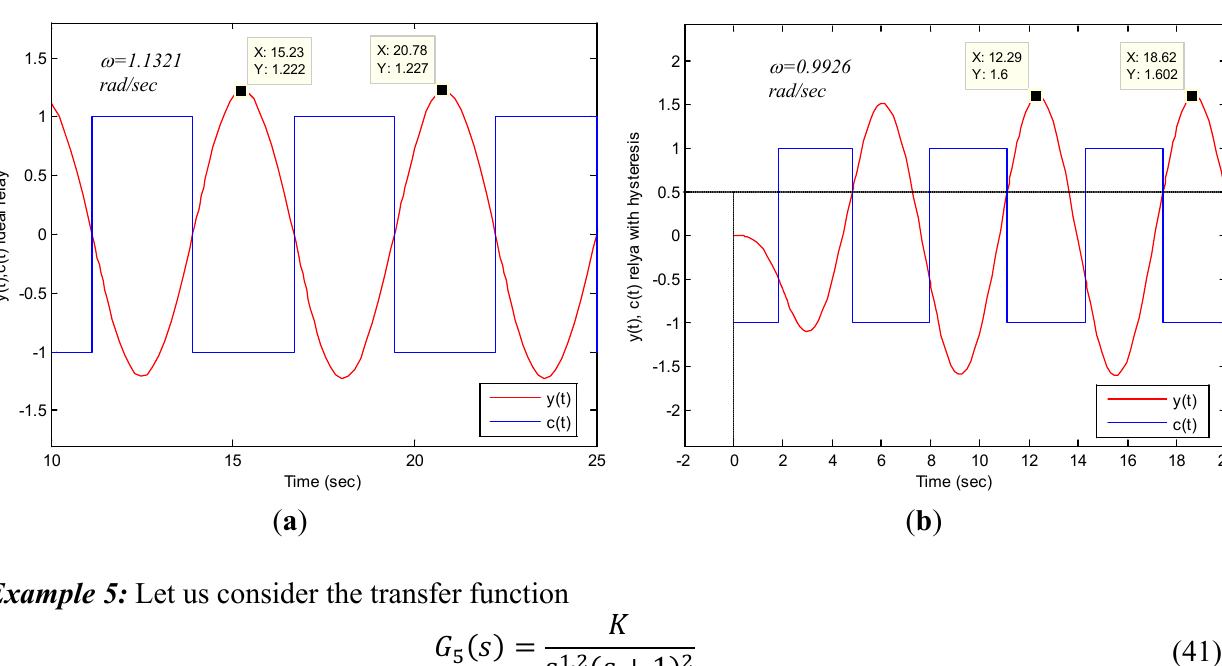
Figure 18. Time responses of closed loop system in Figure 6 with ( b ) relay with